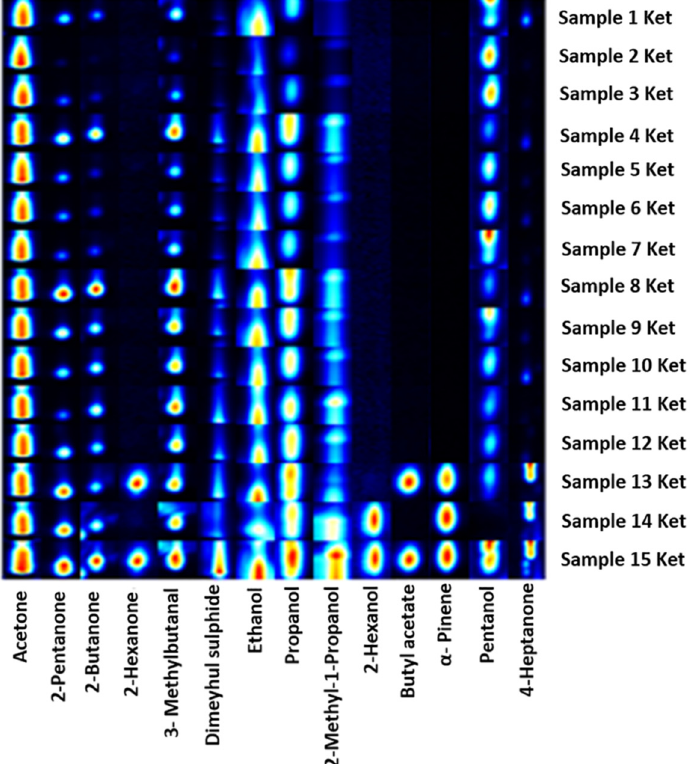
Figure 4. Gallery plot of GC–IMS signals of 14 VOCs species detected in 15 urine samples with ketone bodies value over 60